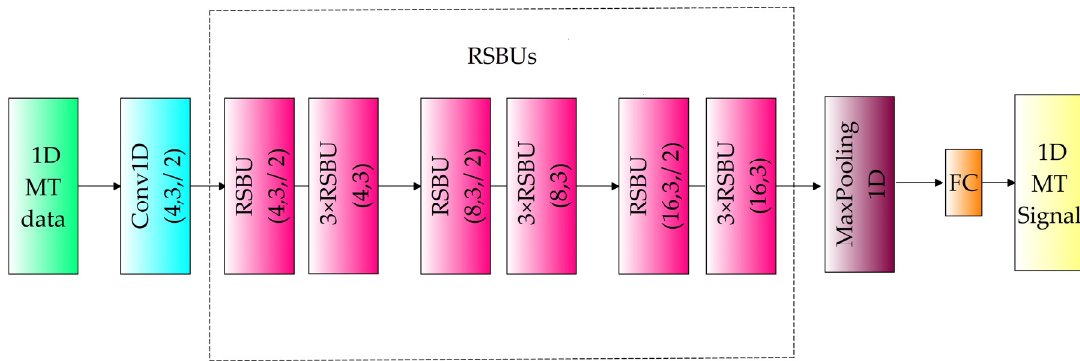
Figure 2. Structure of the DRSN.